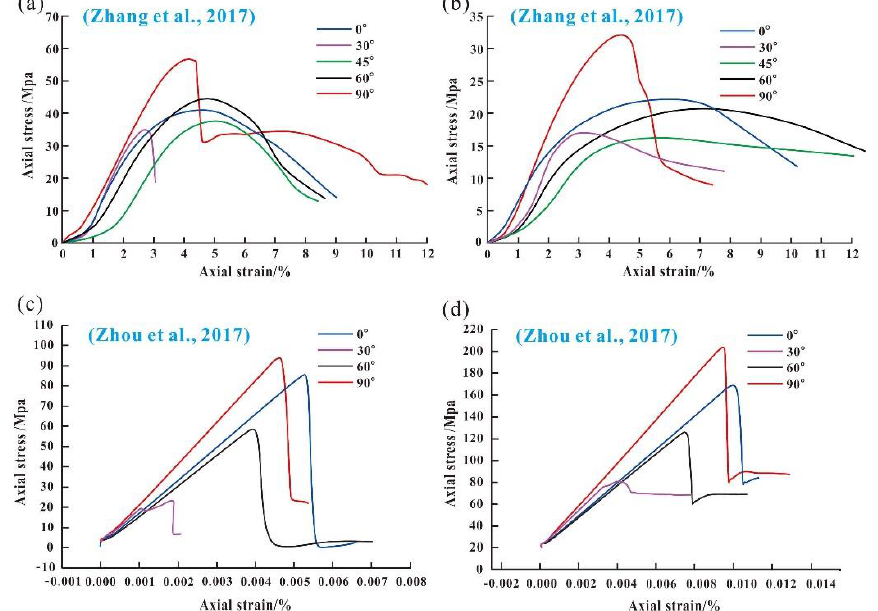
Figure 2. Stress–strain curves of laminated rock tested in previous works. ( a ) Curves tested in Zhang et al. (2017) [59] ; samples are artificial laminated cores tested at 10 MPa confining pressure. ( b ) Curves tested in Zhang et al. (2017); samples are artificial laminated cores tested at 20 MPa confining pressure. ( c ) Curves tested in Zhou et al. (2017) [47]. The peak strength values of these curves are also used to verify the modified Tien–Kuo (T–K) criterion, and the samples are the naturally laminated cores tested at 10 MPa confining pressure. ( d ) Curves tested in Zhou et al. (2017). The peak strength values of these curves are also used to verify the modified T–K criterion, and samples are the naturally laminated cores tested at 20 MPa confining pressure. Table 2. Parameters used to fit the function curves of the failure criteria.